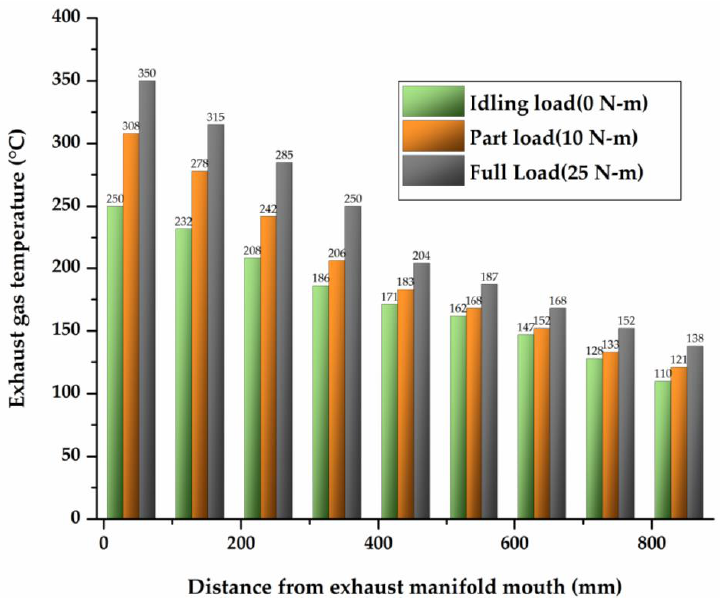
Figure 2. Exhaust gases temperature at different locations.